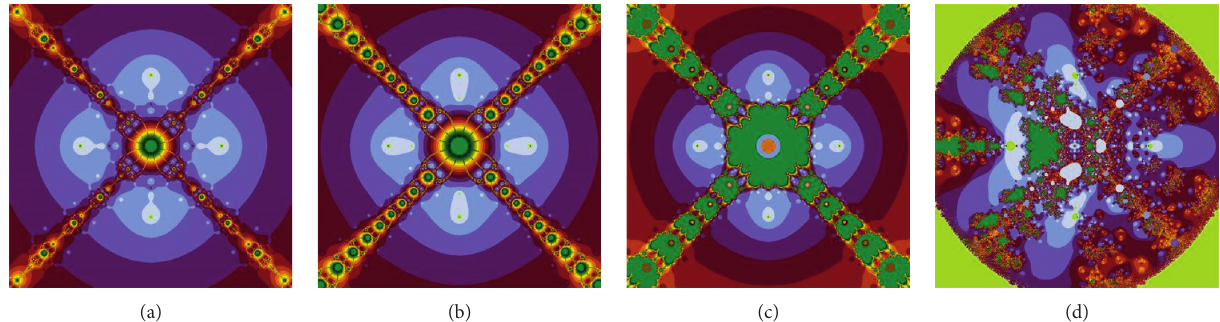
. (a) Ostrowski’s method. (b) Traub’s method. (c) Zhanlav’s method. 4